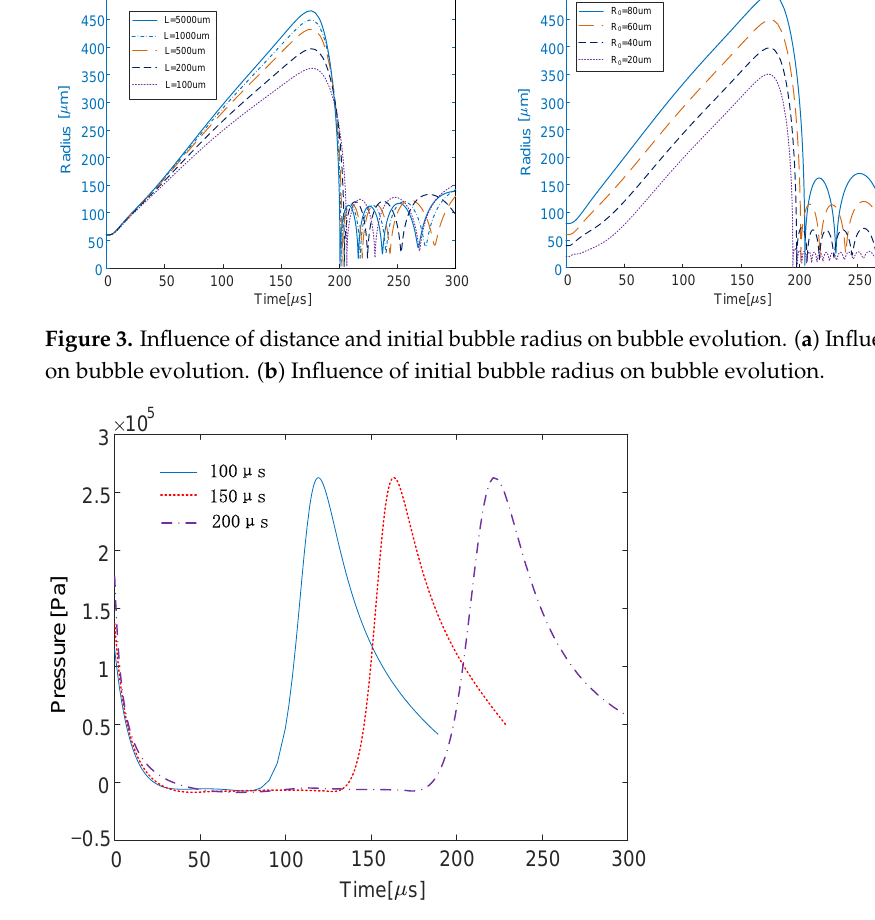
the maximum bubble radius increases with negative pressure period. With longer negative pressure period, evolution process of bubble extends, therefore the bubble radius has more time to grow. The maximum bubble radius increases with distance L, which coincides with Figure